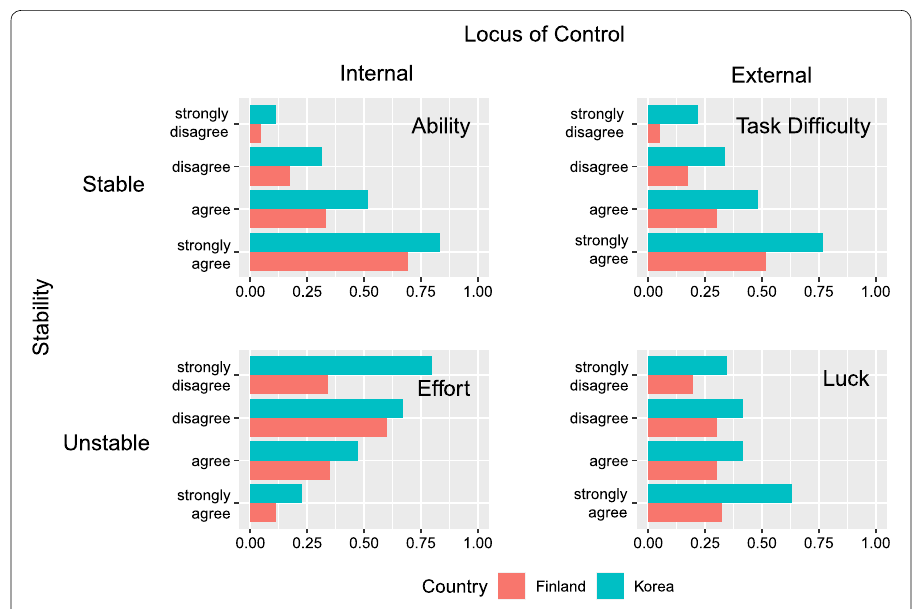
Fig. 3 Probabilities to agree or strongly agree to feeling learned helplessness in Korean and Finnish